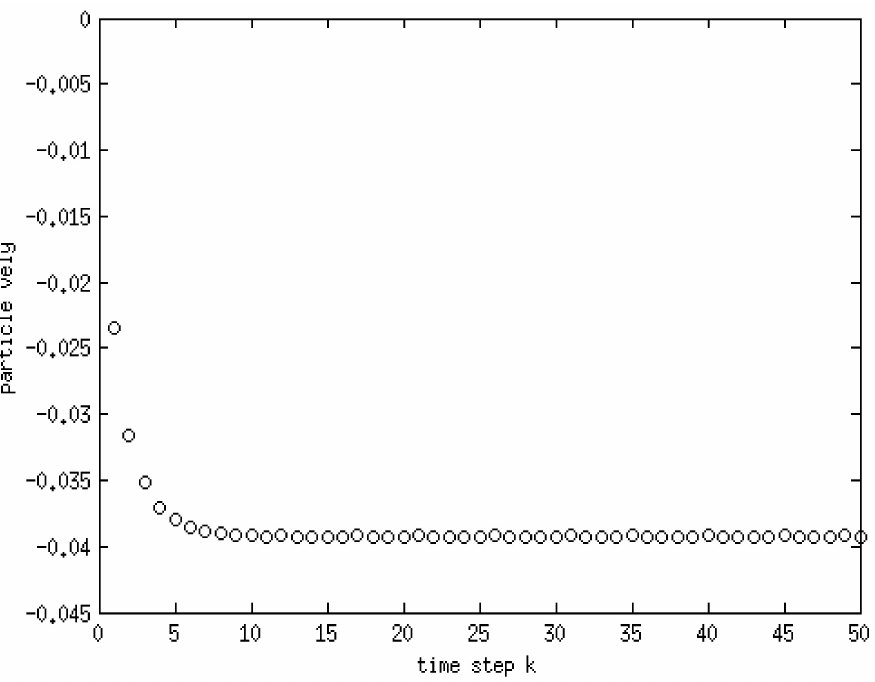
Figure 14. Y-component velocity with